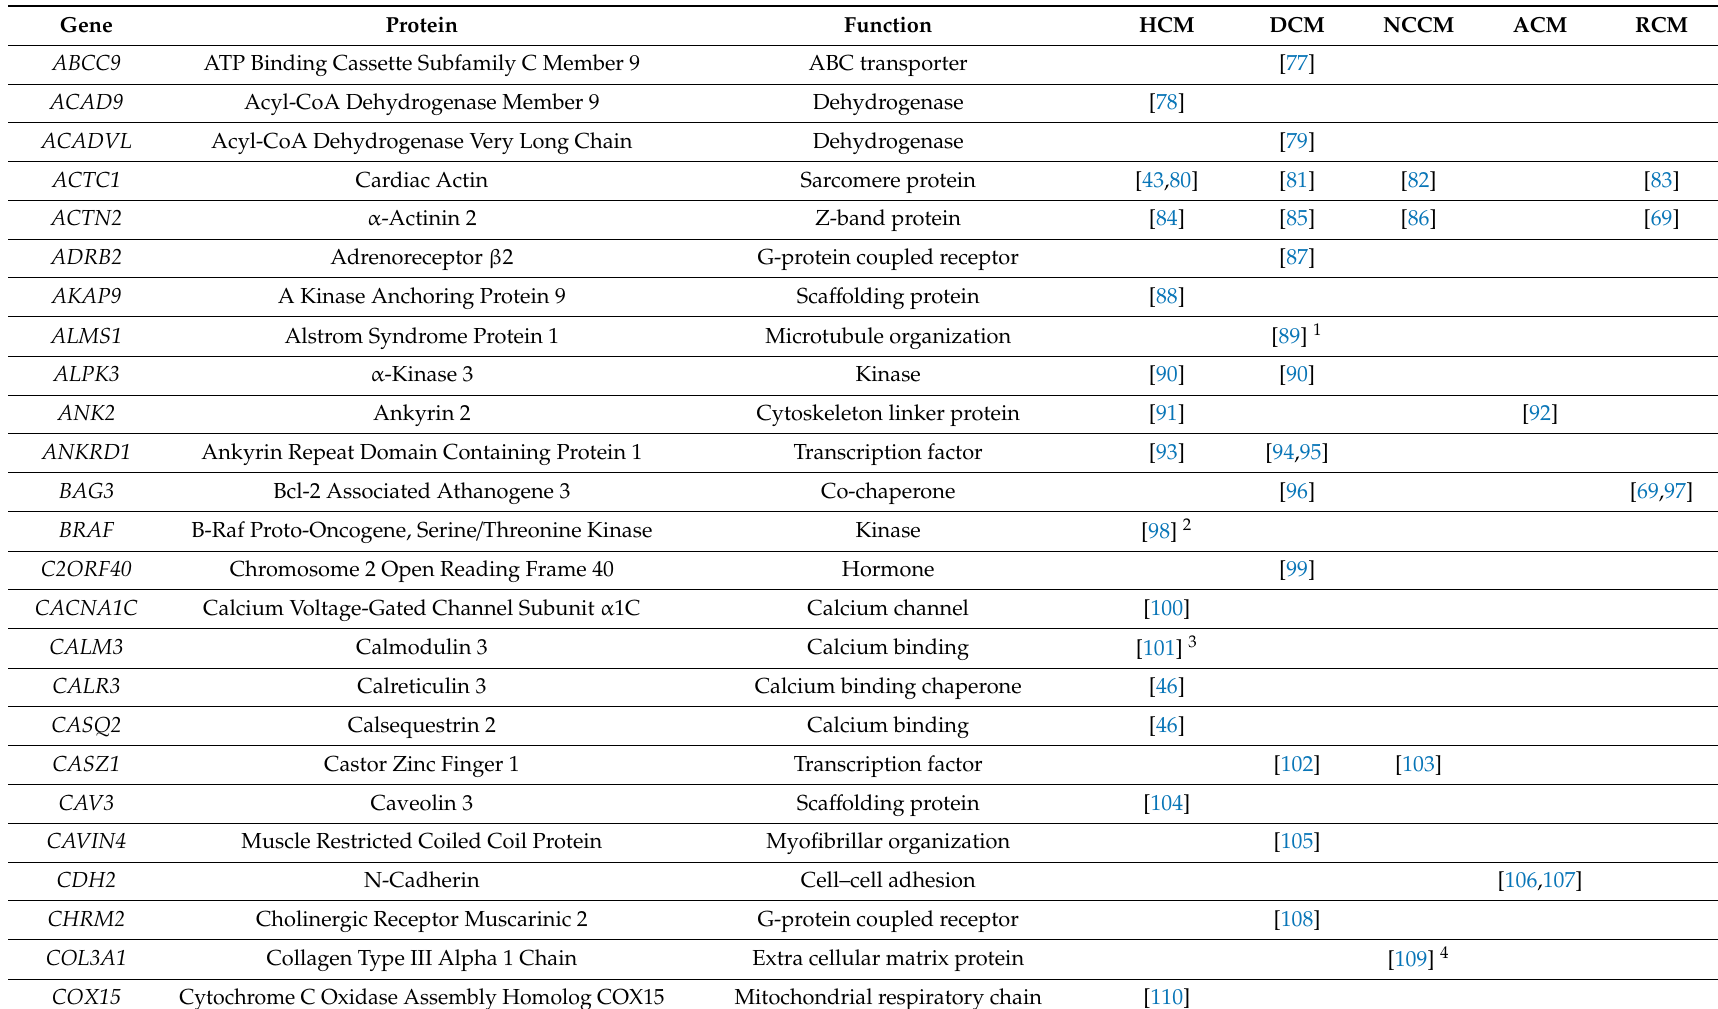
Table 1. Overview of cardiomyopathy associated genes carrying